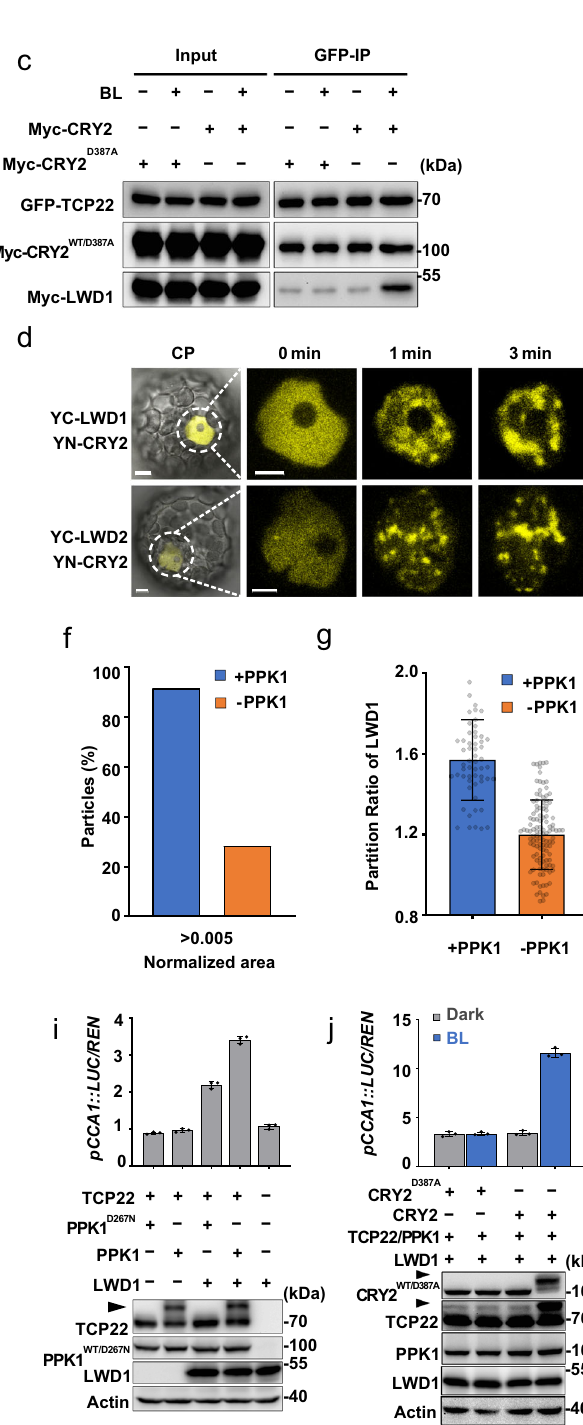
CO 2 in air, at 37°C.HEK-293T cells were seeded at a density of 3×10 5 cells per well in a six-well plate and transfected using PEI-max or the Lipofectamine 3000 methods 27 . For the transfection with PEI-max, different combinations of plasmids (2 – 3 μ g/construct) and 6 μ L 0.1mg/mL PEI-max (Polysciences, Inc) aqueous solution were diluted into a total volume of 150µl of Opti-MEM (Gibco, 11058021) and then kept at room temperature for 5min before being applied for cells per well. For the transfection using Lipofectamine 3000 (ThermoFisher, L3000015), we performed the transfection according to the manufacturer ’ s instructions.